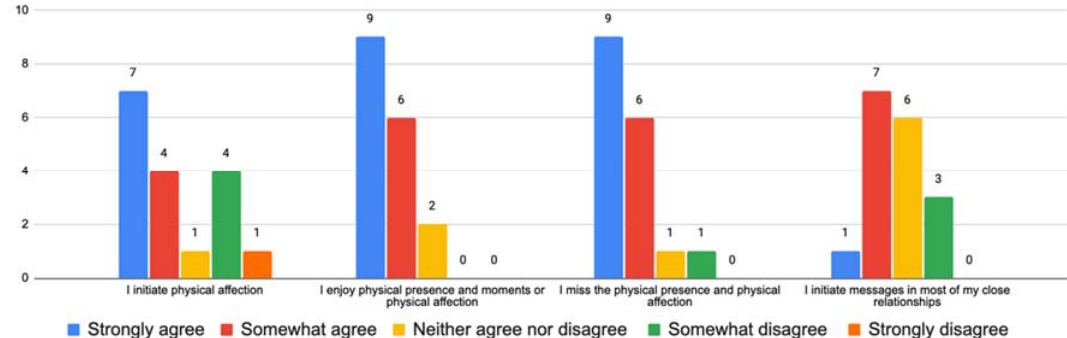
Figure 1. Distribution of physical touch and communication behaviors.